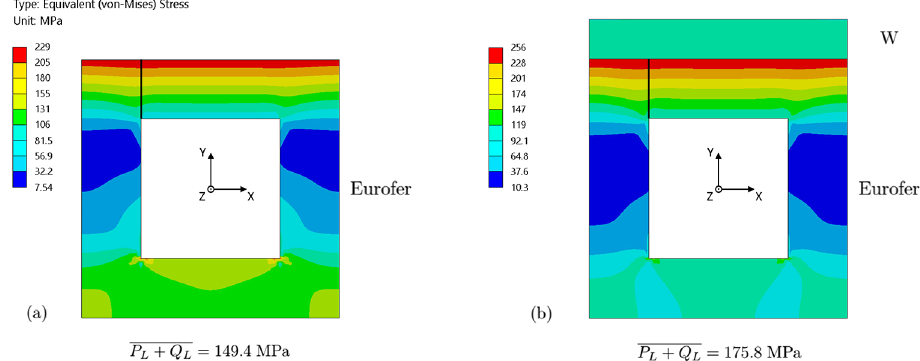
Fig. 3. – Contours of von Mises stress without (a) and with (b) the W domain. The average value used for the criterion is calculated on the black